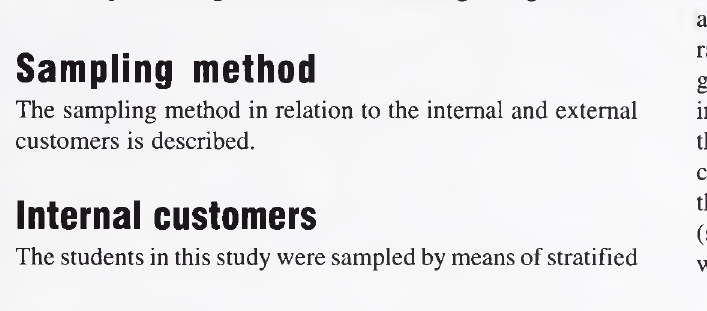
Table 4: Coding system for value clarification THEM ES, CATEG O RIES &